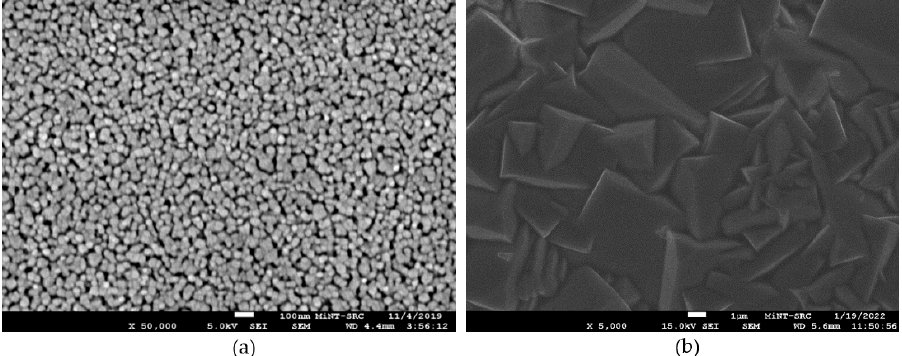
Figure 9. Top-view images ( a ) before and ( b ) after stacking of p-Cu 2 O onto the n-TiO 2 /ZnO bilayer thin film.